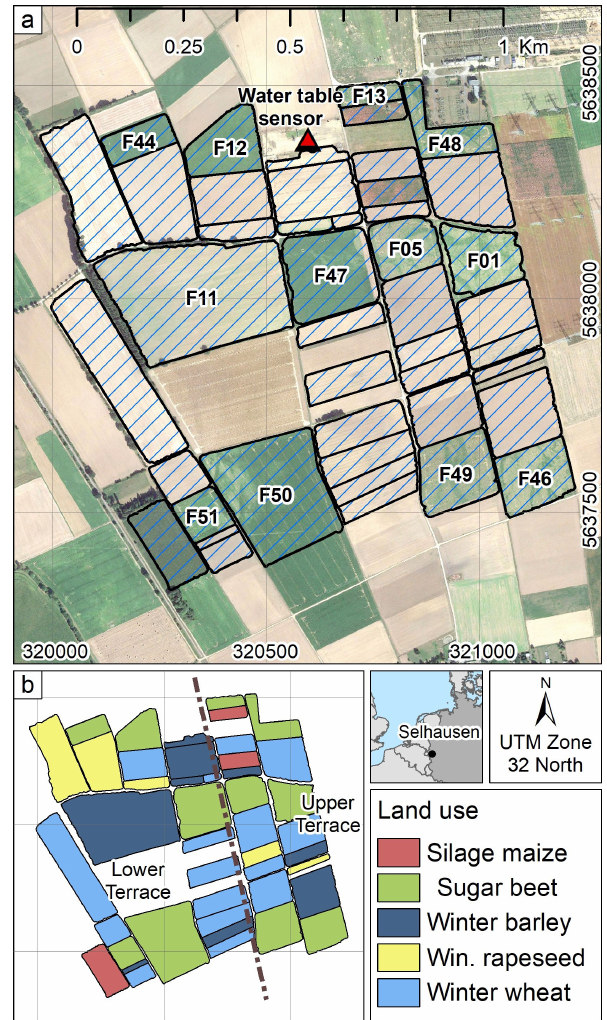
Figure 1. (a) Satellite image of the study area with the fields used for comparison and codes of fields where sugar beet was grown in 2016 and (b) crops that were grown in each studied field in 2016 (ESRI,